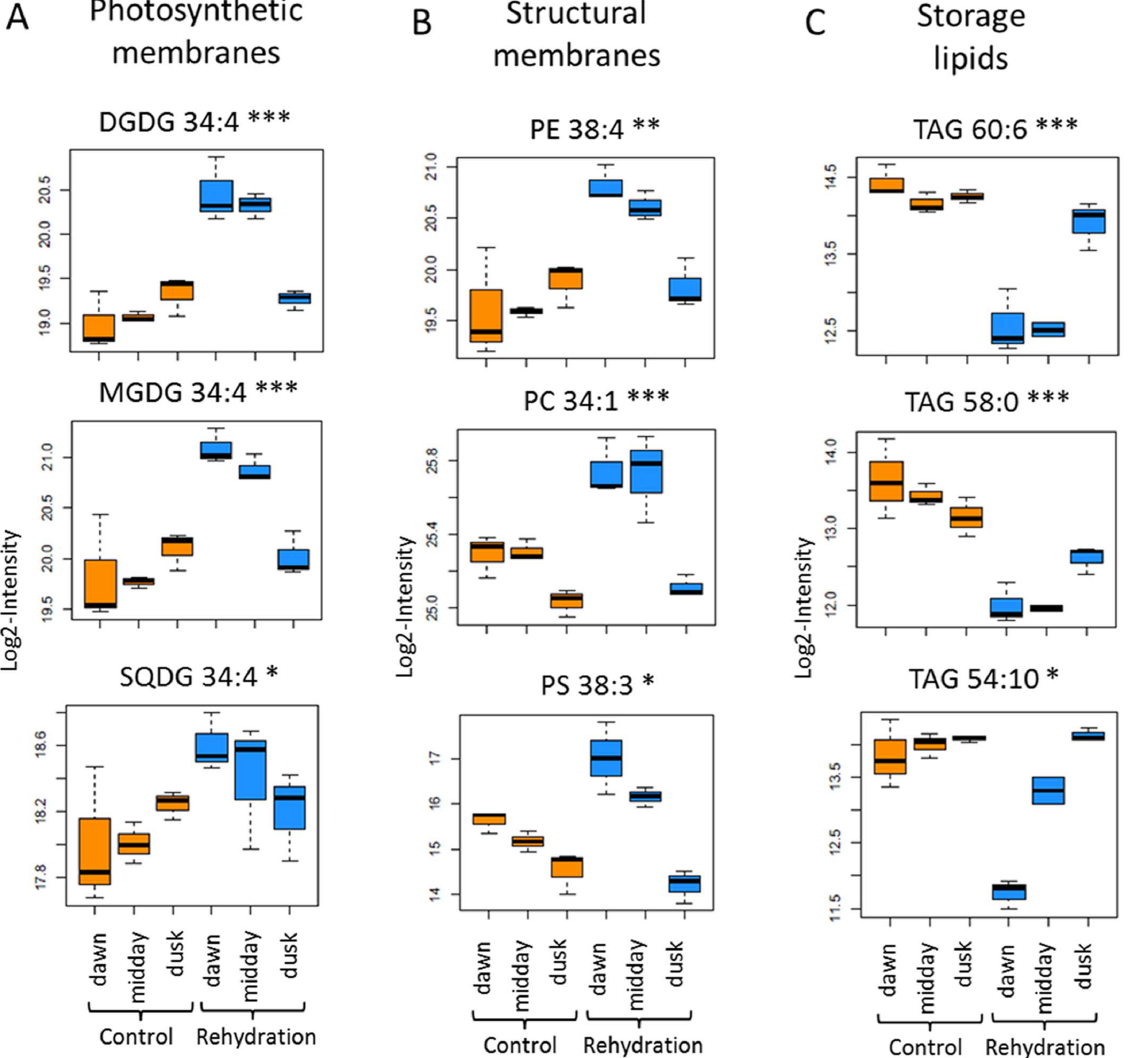
Figure 5. Boxplots of representative species of photosynthetic, structural and storage lipids. Boxplot-visualizations for a subset of complex lipids as determined for the three independent samples for the different time points and treatments as indicated on the x-axis of three replicates that were harvested at 1 h post-dawn, midday and 1 h pre-dusk for control and rehydrated plants.